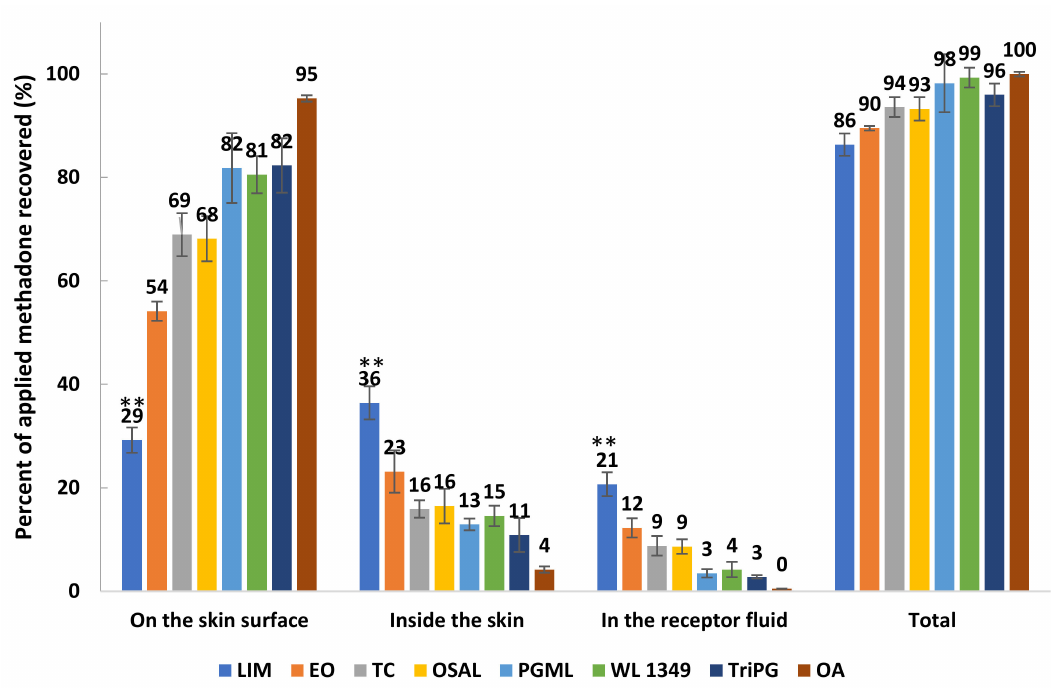
Figure 6. Mass balance results after 24 h finite dose (5 µ L / cm 2 ) permeation studies in porcine skin for 5% ( w / v ) methadone free base in LIM, EO, TC, OSAL, PGML, WL 1349, TriPG and OA at 32 ± 1 ◦ C (mean ± SD; 4 ≤ n ≤ 5). ** p <